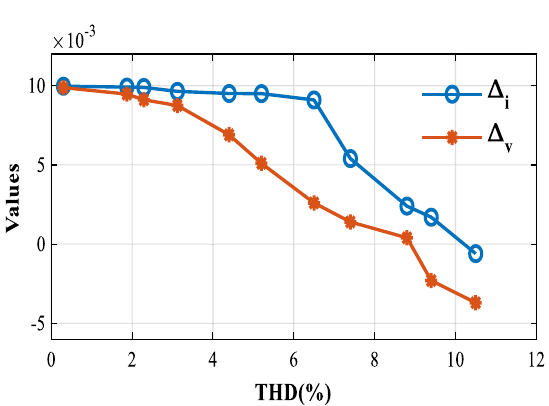
Fig. 21 Harmonic contamination effect on proposed criteria